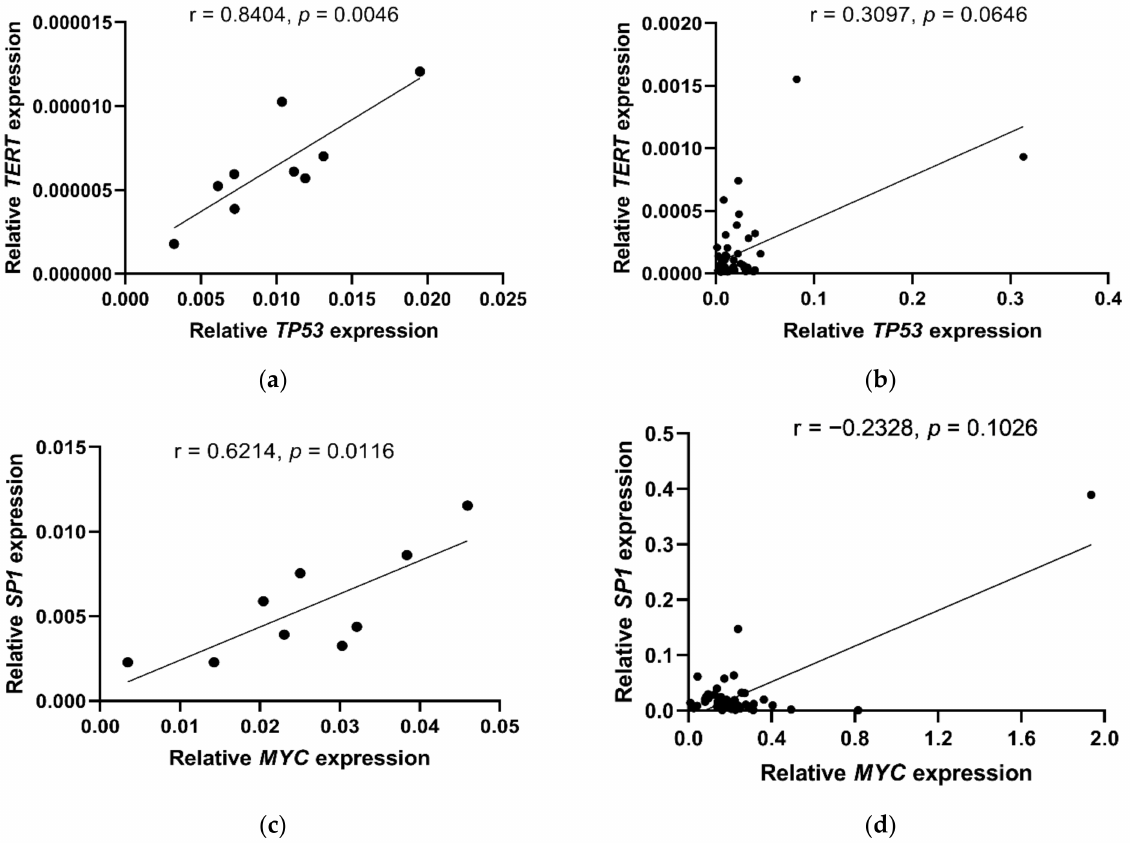
Figure 2. Relationships between expression of TERT , TP53 , SP1, MYC genes observed in BC organoids ( a , c ) and BC patients ( b , d ). Statistical analysis was performed using the Pearson correlation (PC) test ( a , c ) and the Spearman r correlation test ( b , d